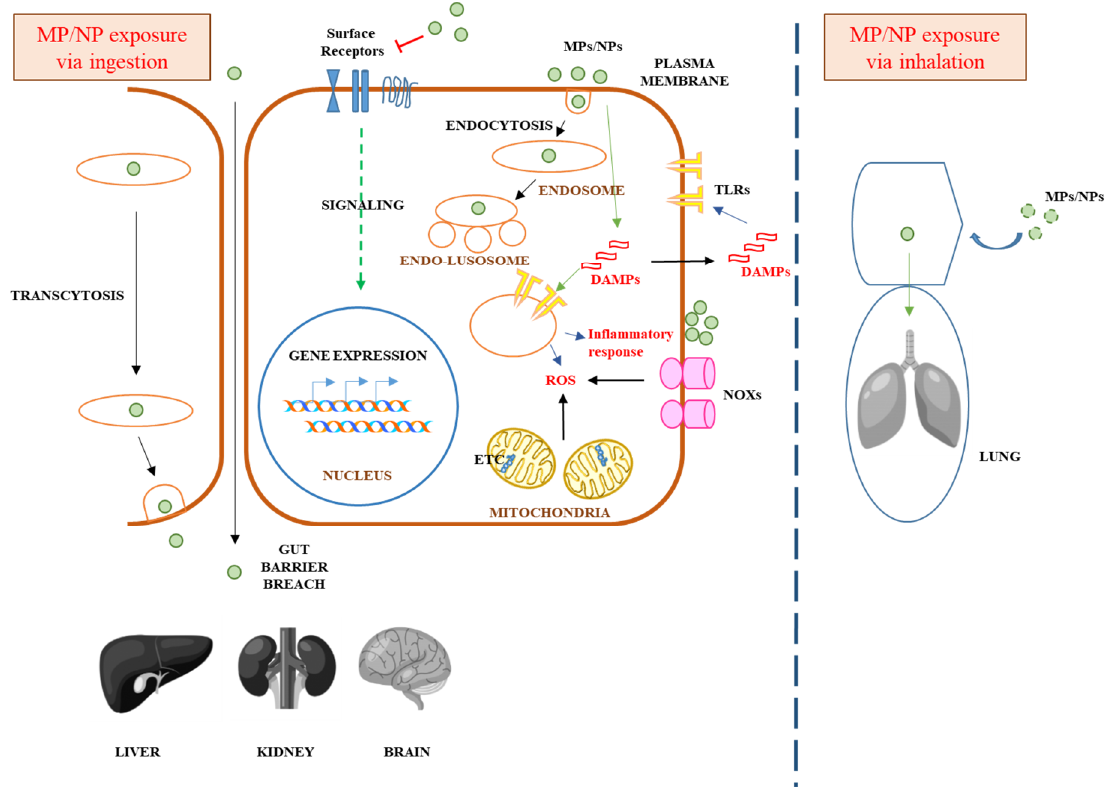
Figure 1. A schematic diagram illustrating potential (speculative at the moment) cellular mechanisms of MP/NP toxicity. MPs/NPs can be taken up through ingestion and inhalation. MPs/NPs could damage the plasma membrane and impair the gut barrier (left). These could also perturb signaling of cell surface receptors, and alter gene expression in the nucleus. Endocytosed MPs/NPs could also perturb the endocytic pathway function and compromise the endosomal membranes. Stresses arising from the above could activate the cellular innate immune system, with endogenous and secreted damage-associated molecular patterns (DAMP) inducing the innate immunity-mediating toll-like receptors (TLRs). Stresses could induce ROS production from the NADP oxidases (NOXs). Mitochondrial impairment, either by MPs/NPs from endosomes or in response to stresses, could also produce more ROS through impairment in the efficiency of electron transport chain (ETC) processes. MPs/NPs gain access into the circulation if the gut–vascular barrier is compromised or it may speculatively occur by transcytosis, thus reaching other organs. The lung probably has a more direct access to airborne MPs/NPs (right).